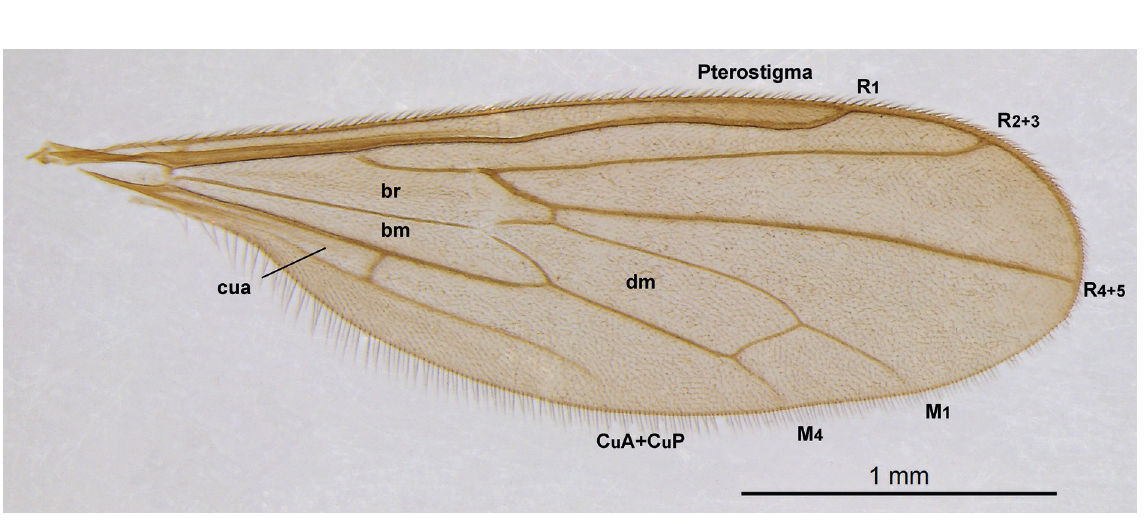
Fig. 3. Chvalaea australis sp. nov. Wing of male paratype (AMS). Abbreviations: bm = basal medial cell; br = basal radial cell; cua = anterior cubital cell; CuA+CuP = anterior branch of cubital vein + posterior branch of cubital vein; dm = discal medial cell; M1 = first branch of media; M4 = fourth branch of media; R1 = anterior branch of radius; R2+3= second branch of radius; R4+5= third branch of